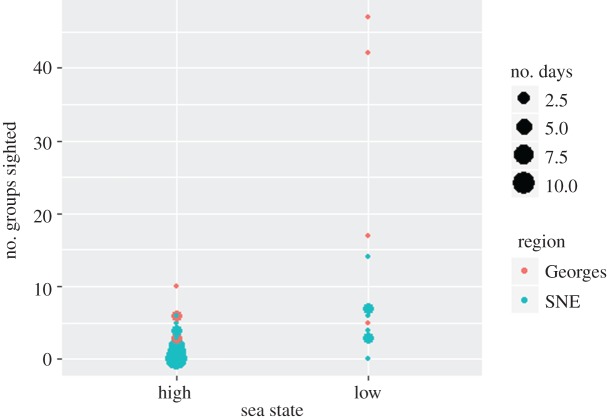
Number of beaked whale groups sighted per day, by sea state and coloured by region. Pink dots represent sightings in the Georges Bank region; blue dots represent sightings in the southern New England (SNE) region.